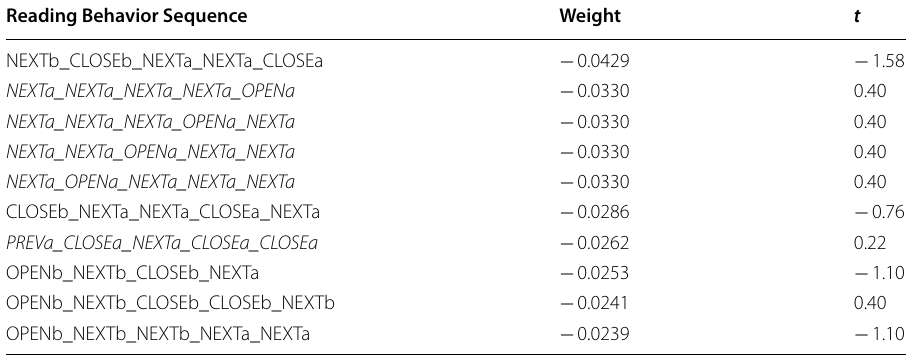
Table 11 Characteristic reading behaviors of low engagement learners Reading Behavior